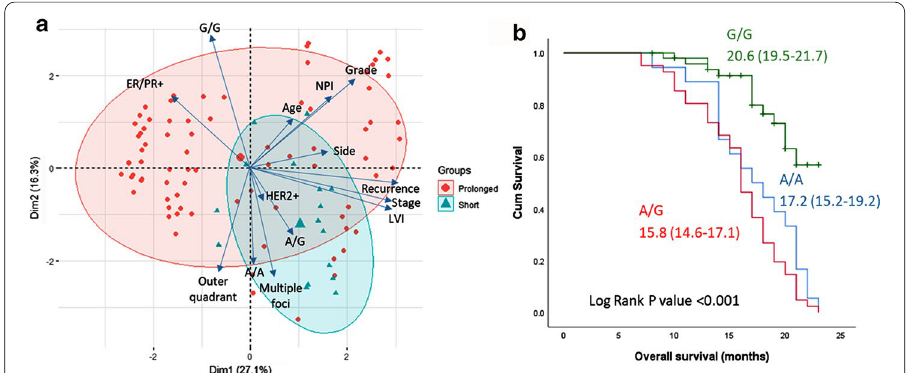
Fig. 4 Impact of CDKN2B-AS1 variant on survival. a Principal component analysis plots the interactions of variables. Each arrow represents a variable with a longer length indicating a greater impact on distribution of the samples. Each observation is symbolized as a triangle (if it has short overall survival) or circle (if it has prolonged survival). Mortality was associated with A/A and A/G genotypes. They were more likely to have ER/PR and HER2 + receptors and multiple foci. b Kaplan–Meier curve showing the mean and confidence − interval duration of overall survival according to their genotype status. G/G homozygote patients had longer survival than their counterparts ( P < 0.001)